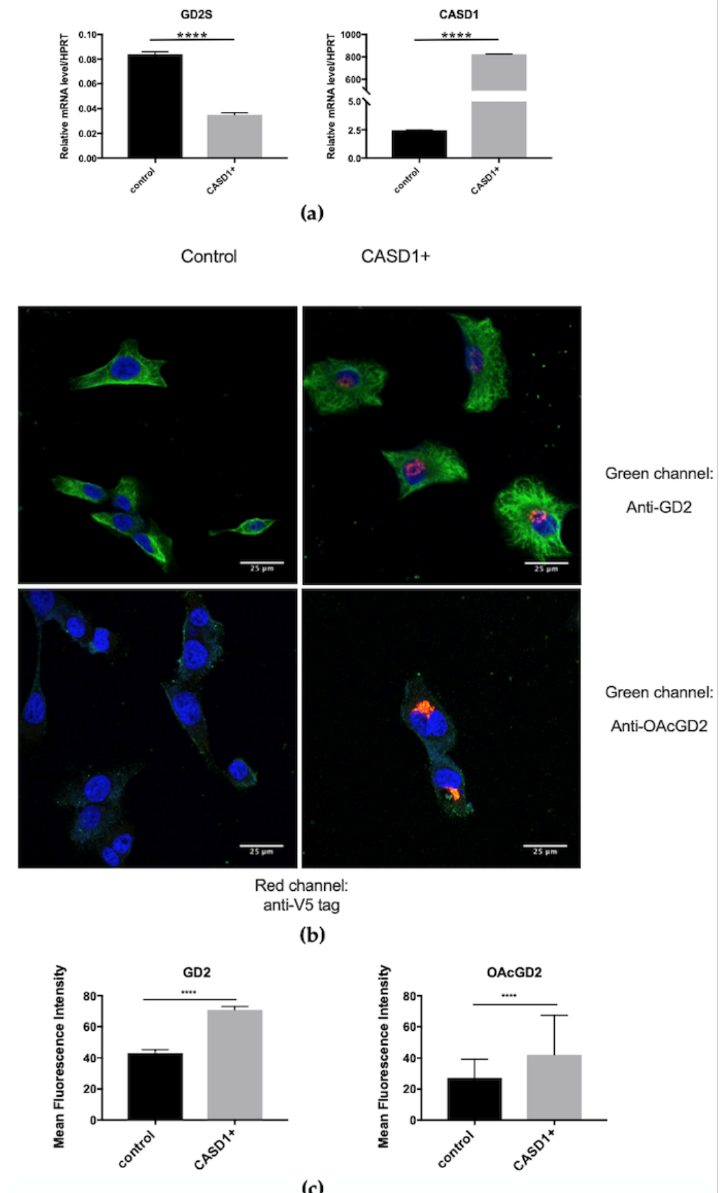
Figure 6. Increased O AcGD2 expression in CASD1 overexpressing SUM159PT cells using plasmid transfection (CADS1+). ( a ) qPCR quantification of GD2S and CASD1 genes in transiently transfected SUM159PT cells ( n = 3). Results were normalized to the expression of HPRT mRNA. ( b ) Representa- tive images of the analysis of GD2, O AcGD2 and V5-tag expression in BC cells by immunochemistry and confocal microscopy ( n = 3). The cells were incubated with anti-V5-tag and either anti-GD2 or anti- O AcGD2 mAbs. Gangliosides were visualized using IgG conjugated-Alexa Fluor 488 and V5-tag using IgG conjugated-Alexa Fluor 546. The nuclei were counterstained with DAPI. All of the images were taken in the same settings. Scale bar: 25 µ M. ( c ) Quantification of mean fluorescence intensity of GD2 and O AcGD2. Statistical difference using unpaired t -test: **** p < 0.0001; ns: